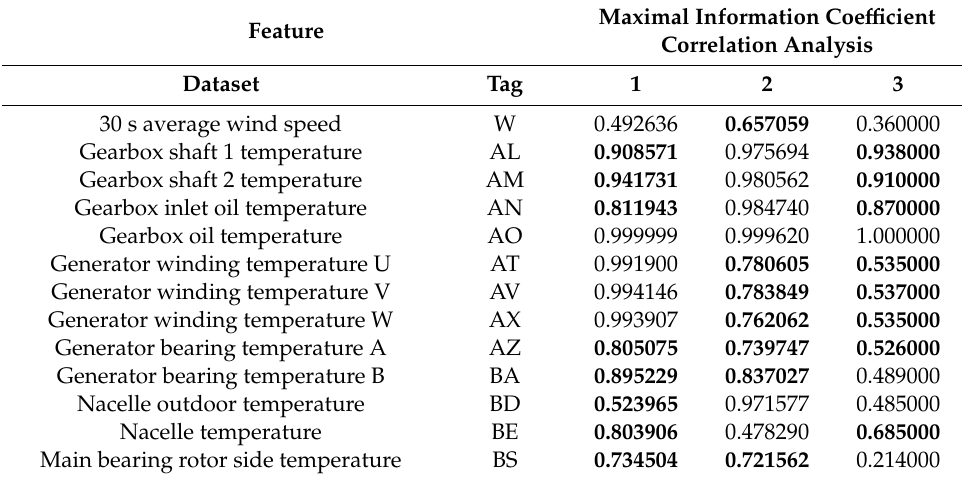
Table 3. Gearbox features correlation analysis results.